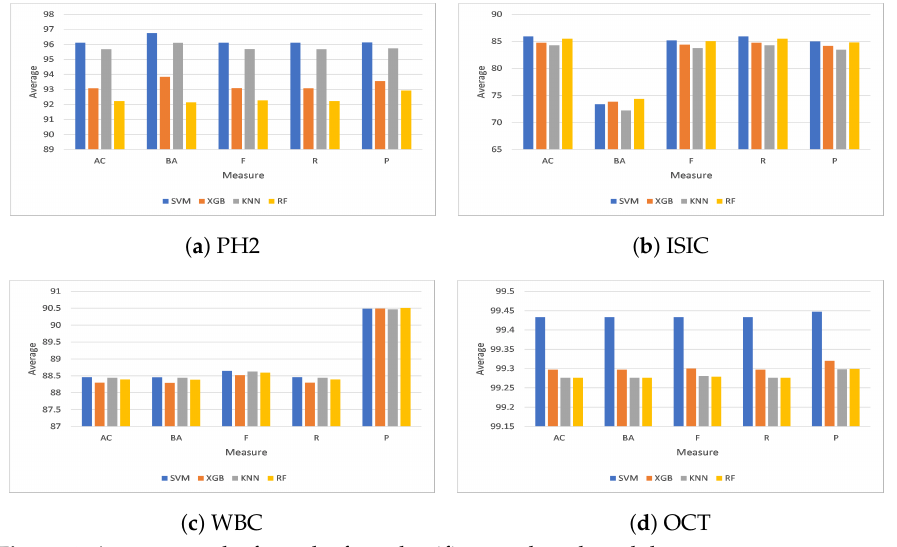
Figure 4. Average results from the four classifiers on the selected